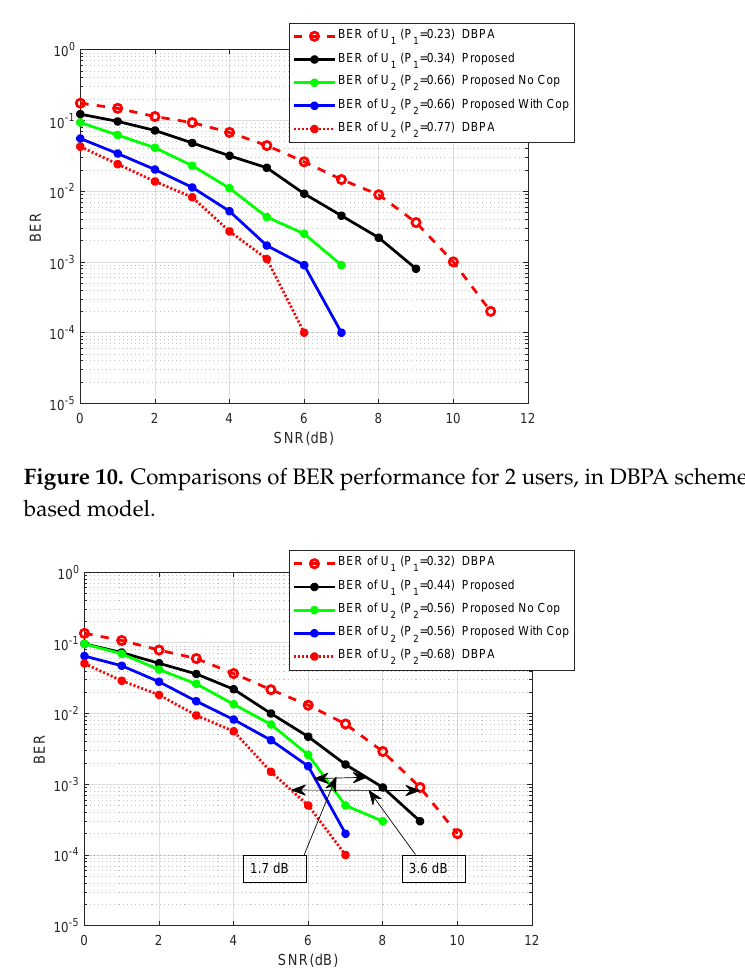
Figure 11. Comparisons of user fairness, in DBPA scheme [18] and the proposed FIS based model for two users in terms of the difference between obtained SNR